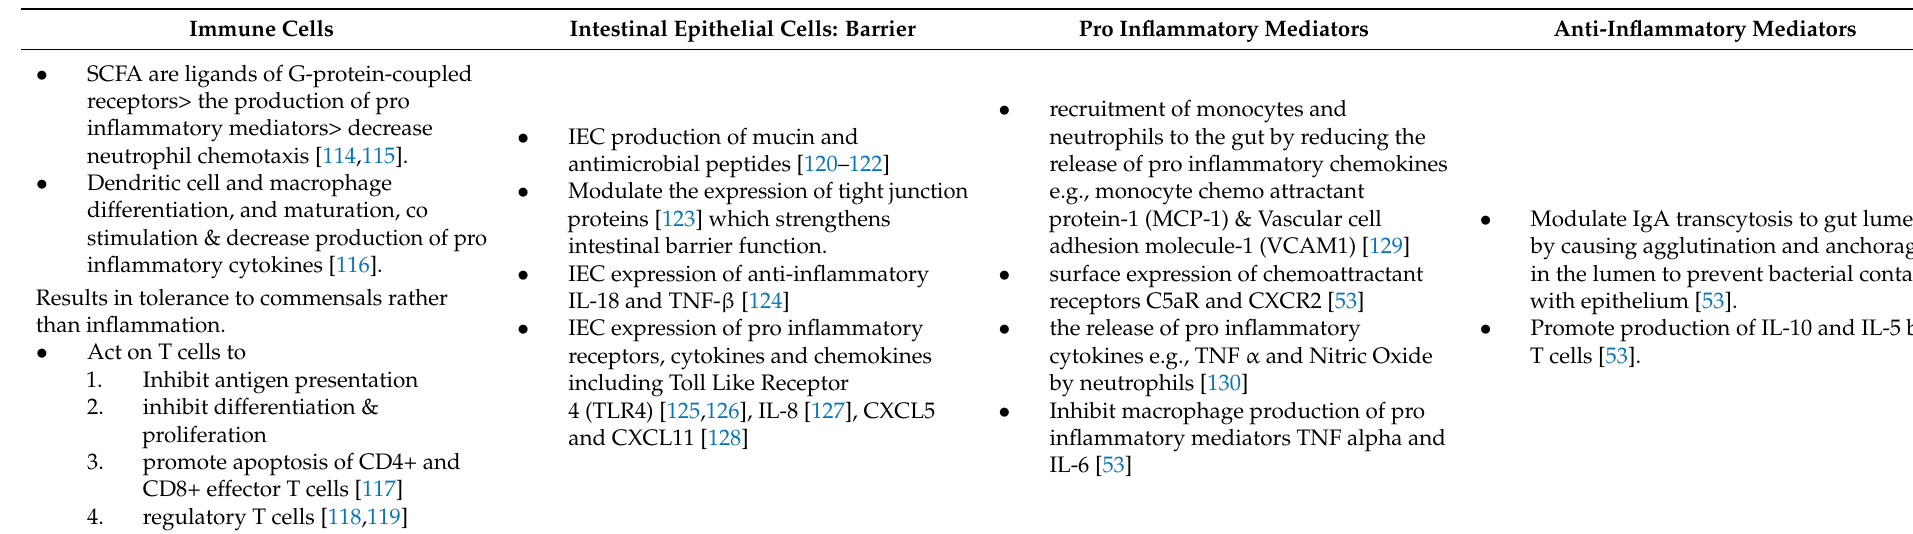
Table 3. Immune interactions of short-chain fatty acids